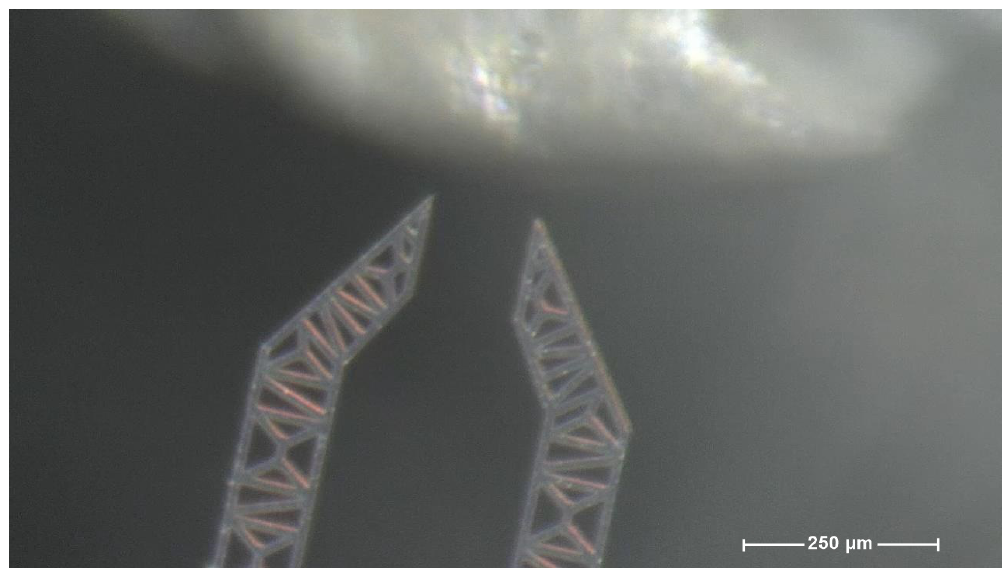
Figure 4. A frame from the sequence illustrated in the Figure 5